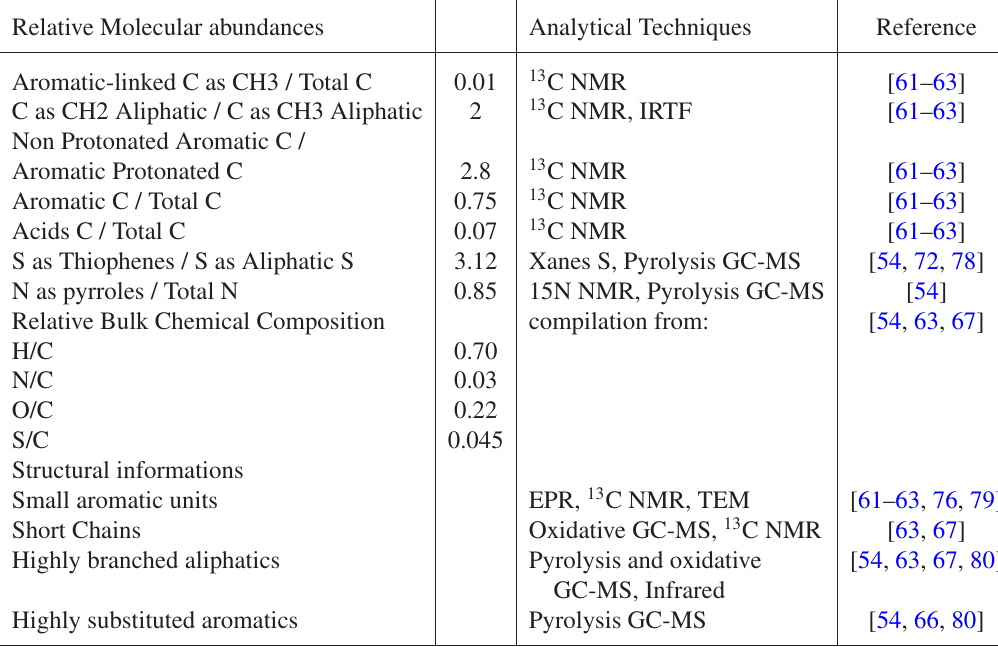
Table 2. Summary and compilation of molecular parameters for Orgueil and Murchison IOM from data collected over the last 20 years. Relative Molecular